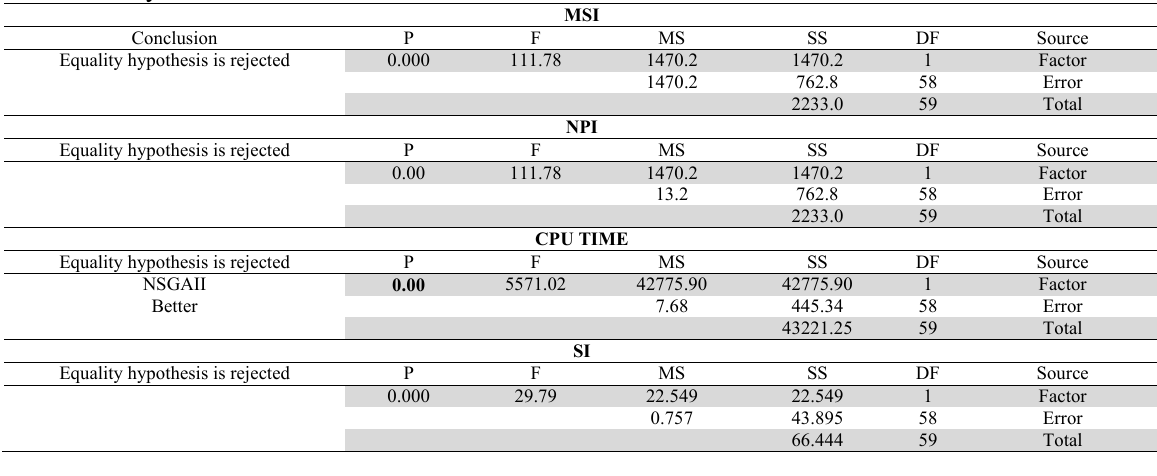
The summary of the